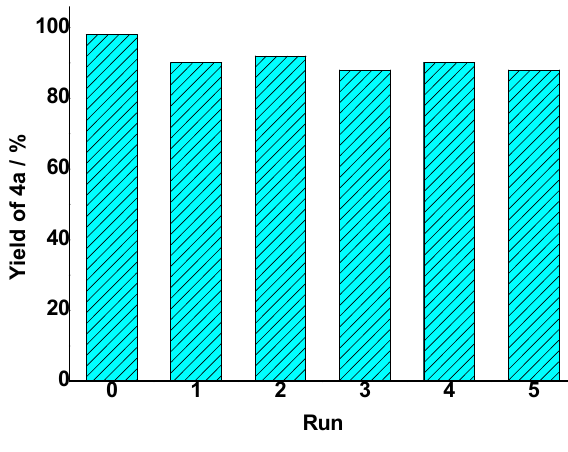
][EtNHC SO ] aqueous solution in the model aldol 2222 3 3